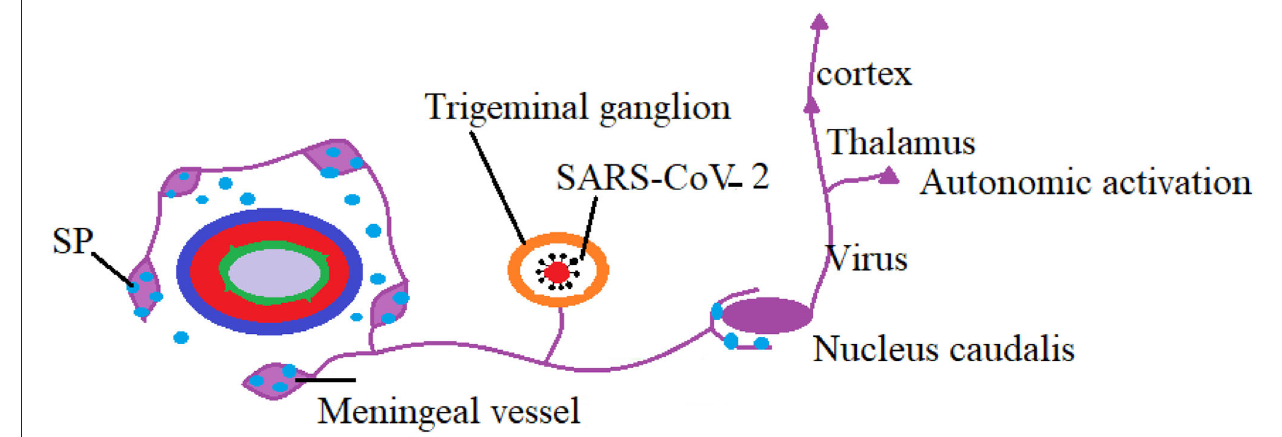
FIGURE 4 | SARS-CoV-2 virus in trigeminal